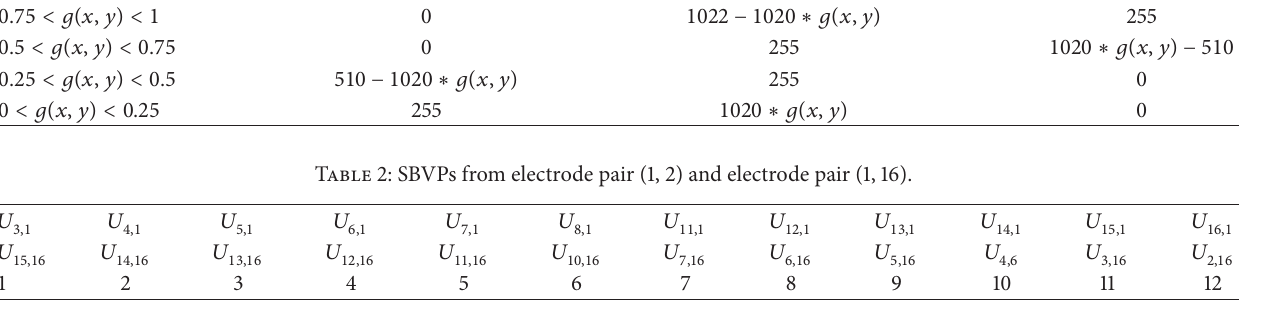
Table 3: SBVPs from electrode pair (2, 3) and electrode pair (16, 15).